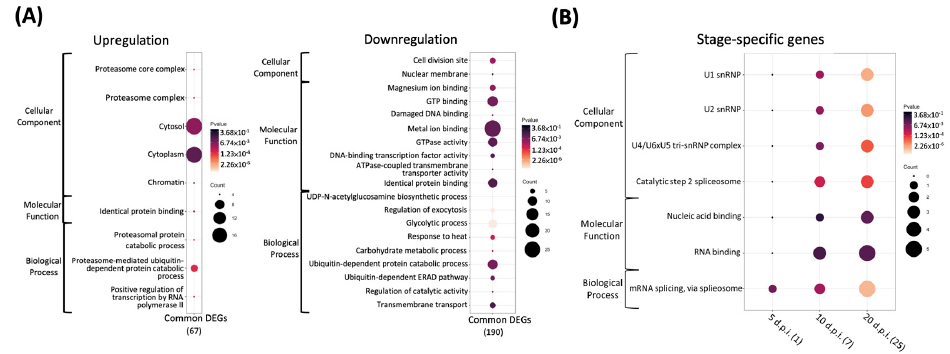
Figure 4. Dot plot of N. ceranae Gene Ontology (GO) term enrichment analysis, showing the enriched pathways with p < 0.05. ( A ) Core genes; ( B ) stage-specific genes. Each trial is indicated at the bottom; the total number of regulated genes within the GO pathways selected on the dot plot are indicated in brackets. Colors indicate the p values from Fisher’s exact test, and the dot size is proportional to the number of DEGs and common DEGs in the